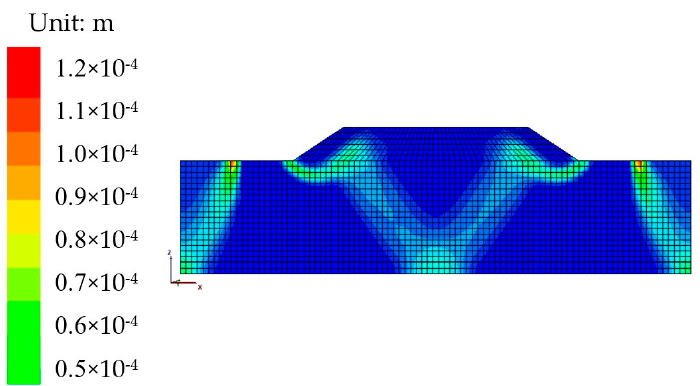
Figure 8. Shear strain increment contour of the model with ELB (H = 6 m, B = 10 m).